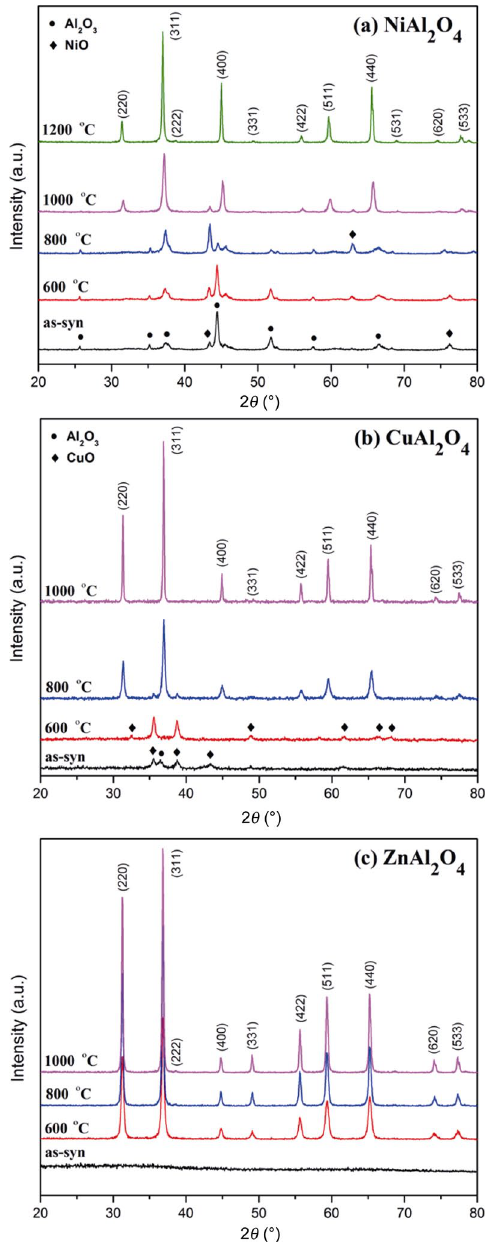
Fig. 1 XRD patterns of (a) NiAl 2 O 4 , (b) CuAl 2 O 4 , and (c) ZnAl 2 O 4 powders calcined at different